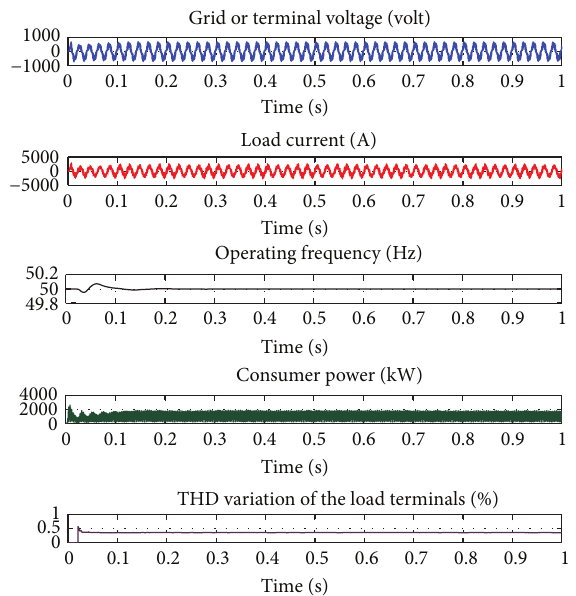
Figure 8: Cases of PMGS-based VSWECS containing IGBT-PWM converter feeds 800kW consumer power in 1KHz switching fre- quency, variation curves of terminal voltage, load current, operation frequency, consumer power, and